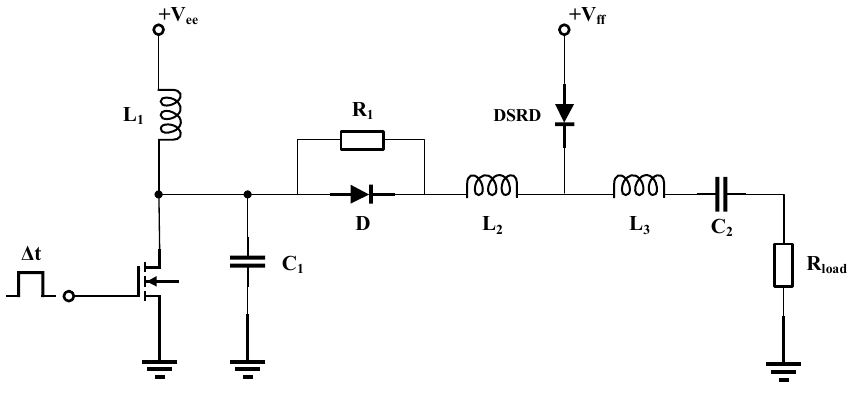
Figure 3. Pulse test circuit based on SiC DSRD.